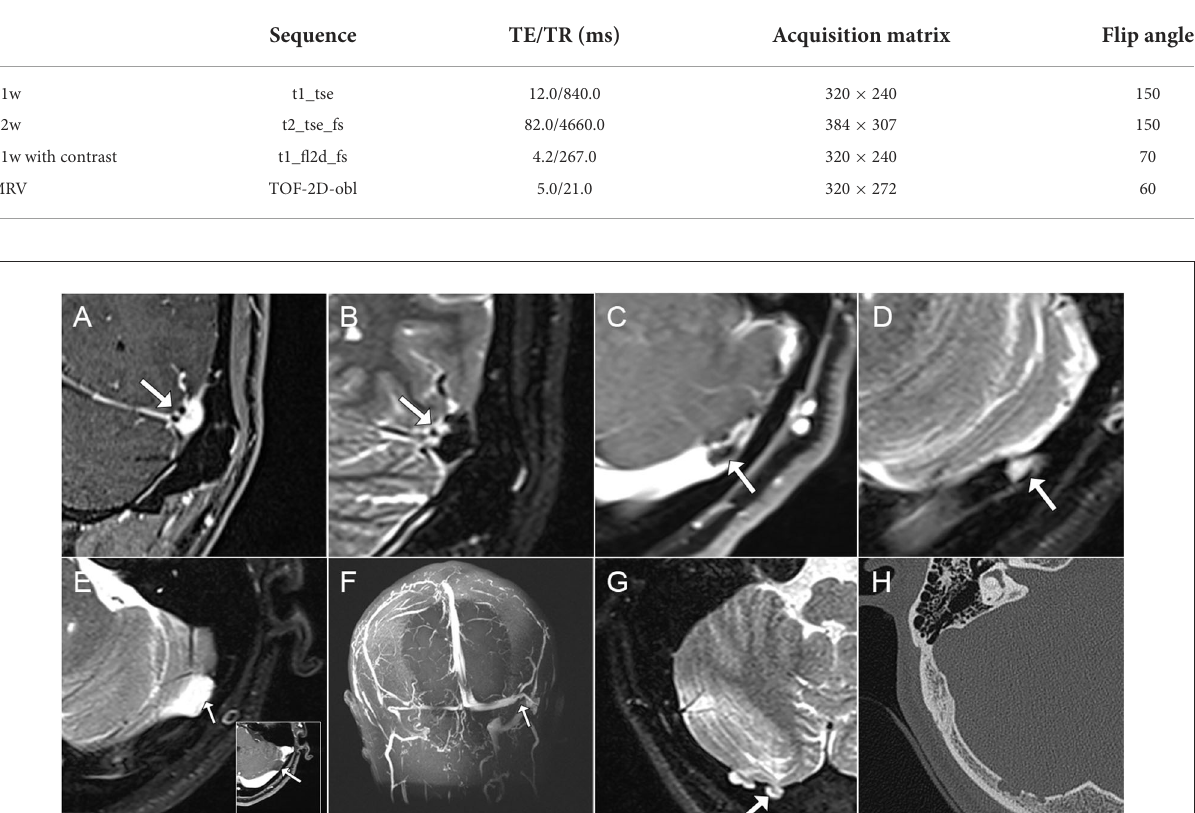
TABLE 1 Sequences and parameters of magnetic resonance (MR) imaging.